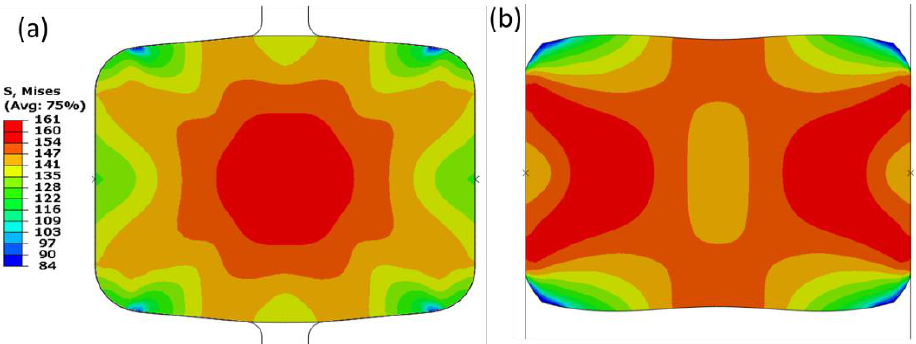
Figure 11. Von Mises stress distribution on the deformed strip after strip deformation by stand 14. ( a ) Strip deformed by grooved rolls; ( b ) strip deformed by grooveless rolls. The strain distribution (Figure 12) indicates a similar pattern as stress (Figure